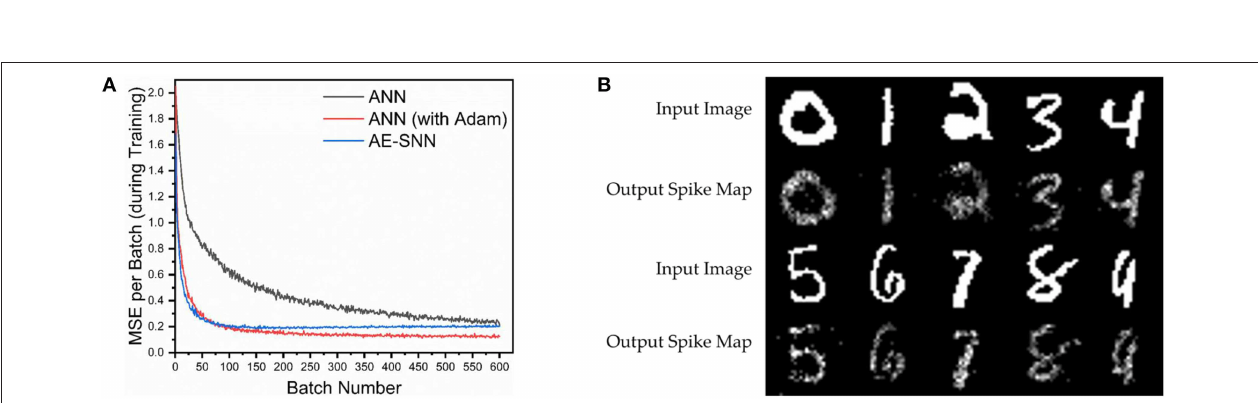
FIGURE 5 | AE-SNN trained on MNIST (training examples = 60,000, batch size = 100). (A) Spiking autoencoder (AE-SNN) vs. AE-ANNs (trained with/without Adam). (B) Regenerated images from test set for AE-SNN (input spike duration = 15, leak = 0.1).